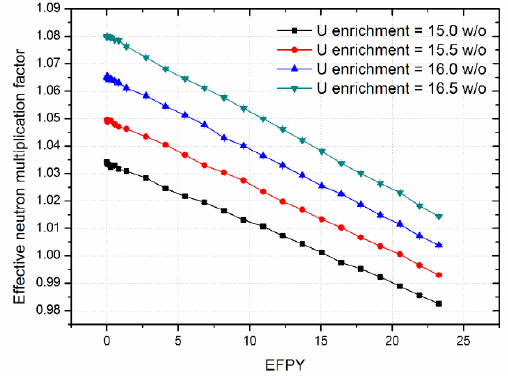
Figure 7. Depletion results with different U enrichment for the MMR.